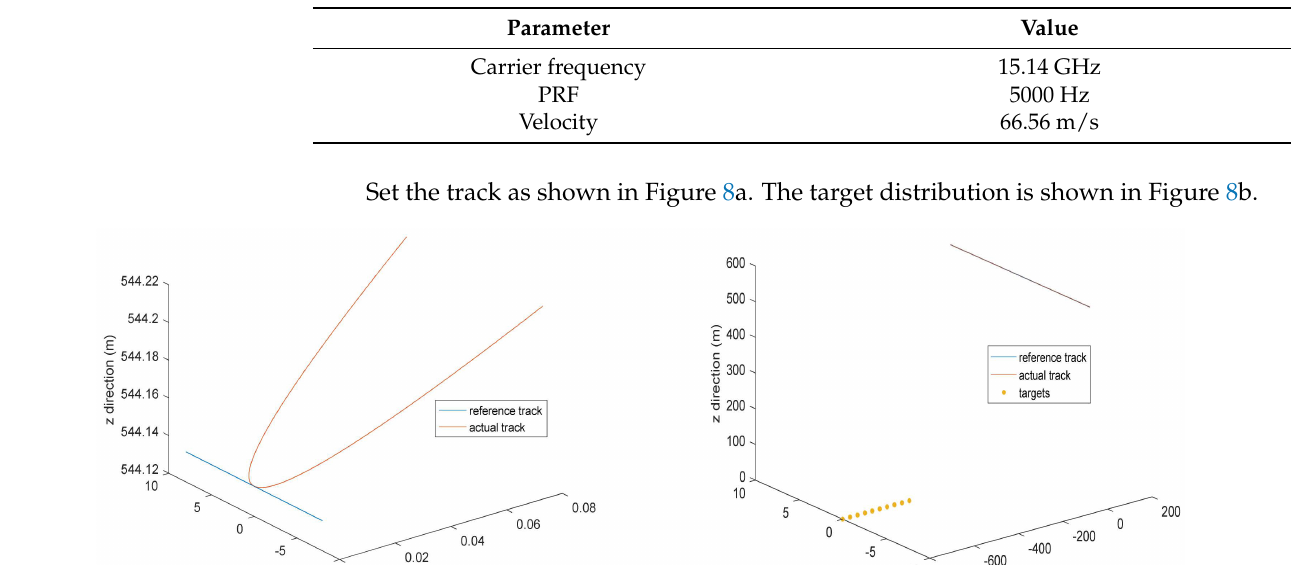
Table 3. Parameters of simulation experiments.